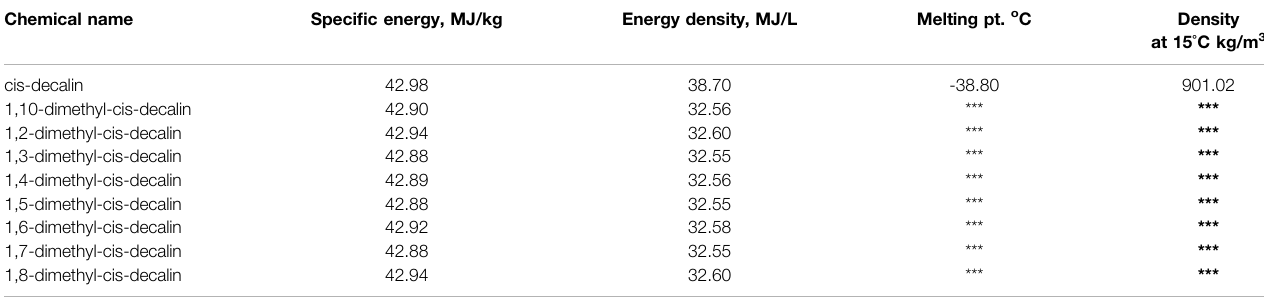
TABLE 3 | Physical properties of cis-decalin and some dimethyl-decalins analyzed in this work. Chemical name